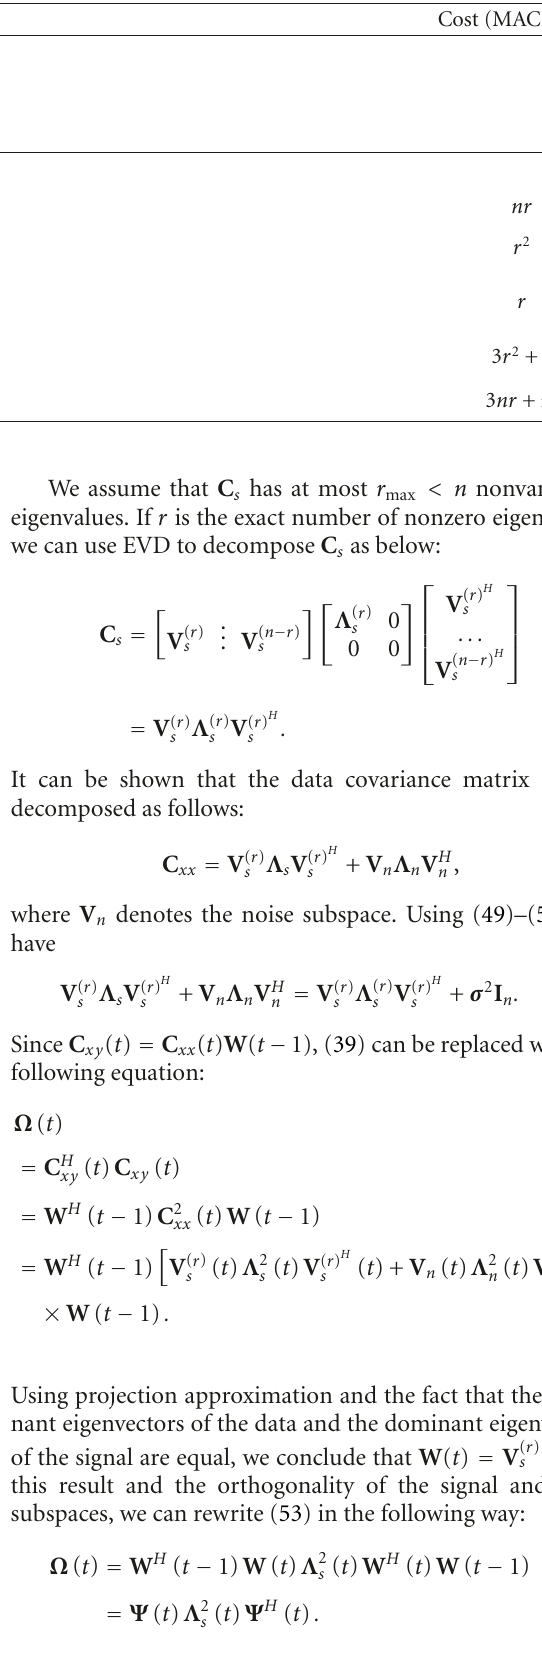
Table 3: Exponential window fast CPAST algorithm.